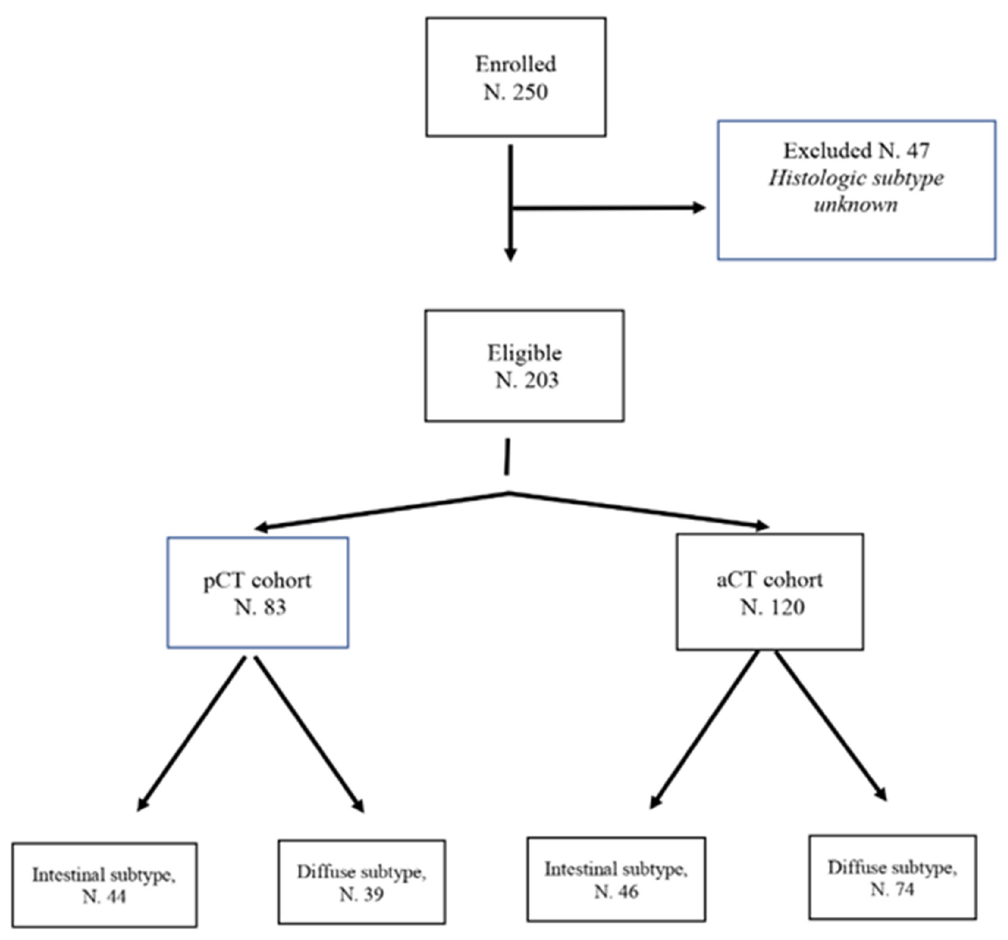
Figure 1. Consort diagram.